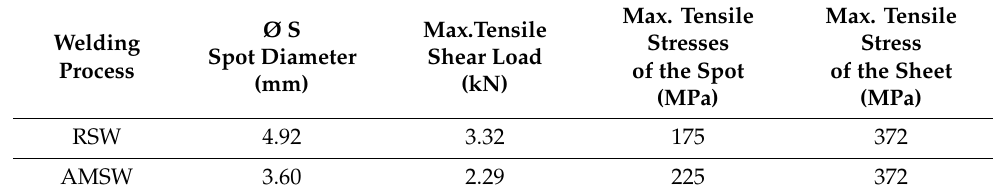
Table 7. Maximum tensile stress for cross-tension test of the weld spots and the sheet (average of three samples).